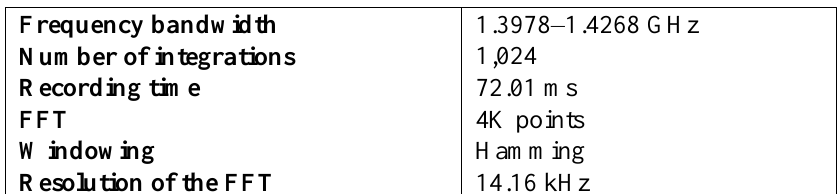
Table 2. Spectrum analyzer specifications.